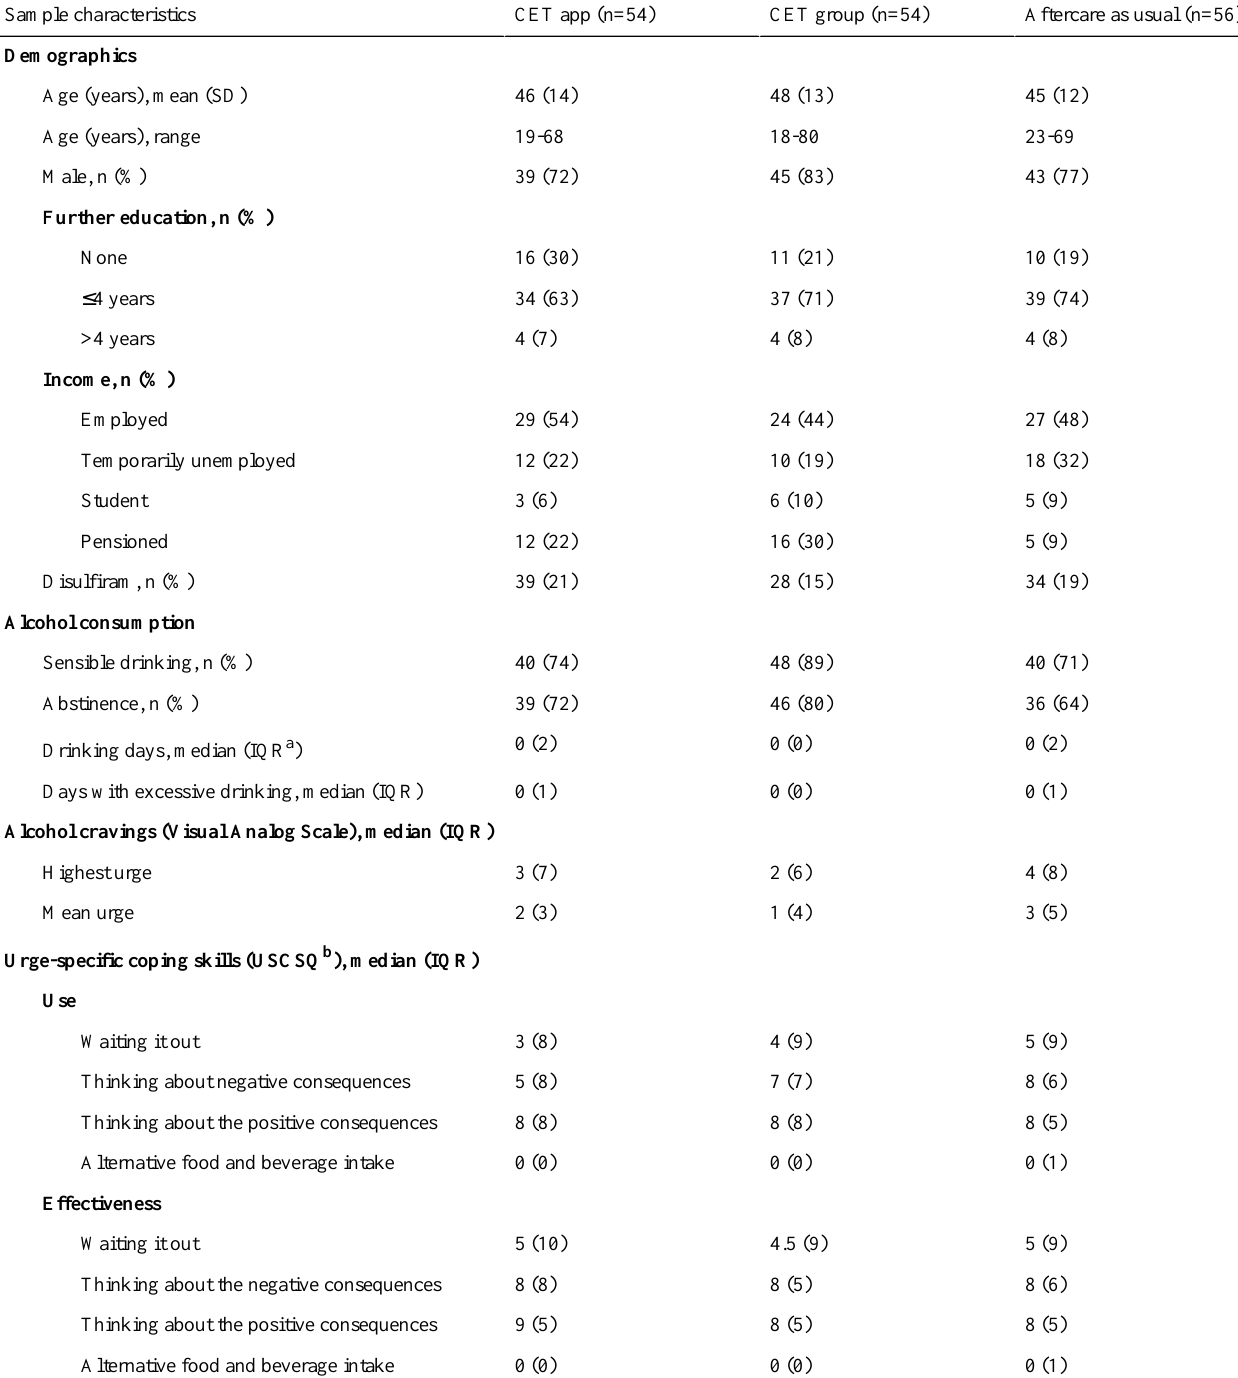
Table 1. Sample characteristics before aftercare treatment with cue exposure treatment (CET) or aftercare as usual